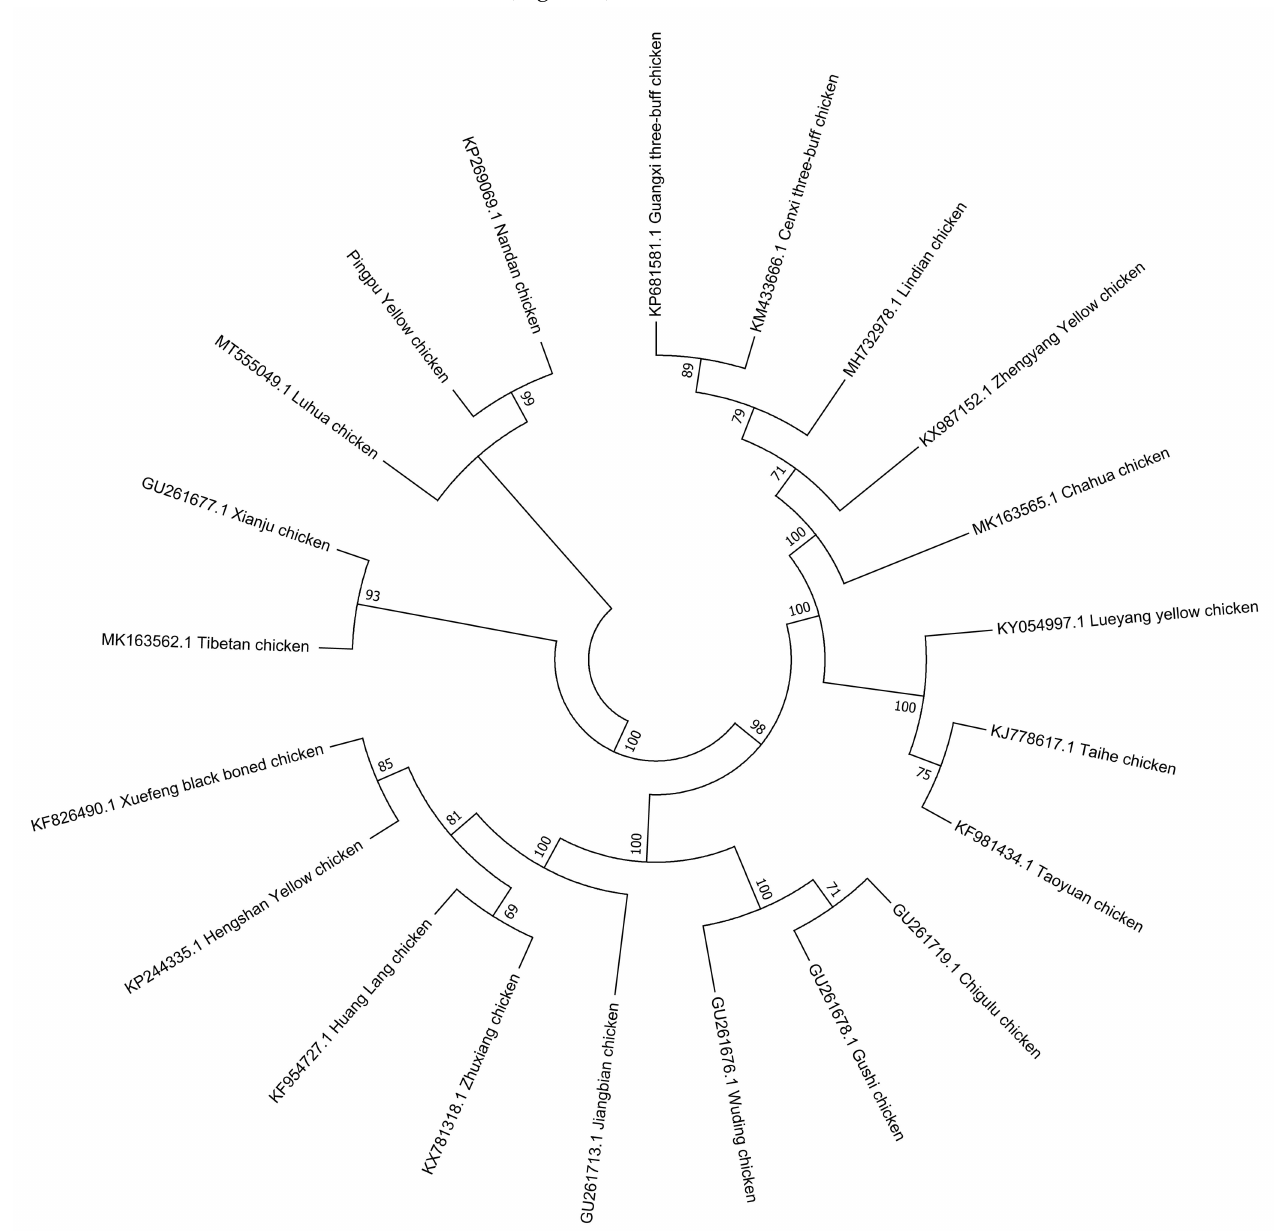
Figure 6. Evolutionary relationships of the Pingpu Yellow chicken and other chicken